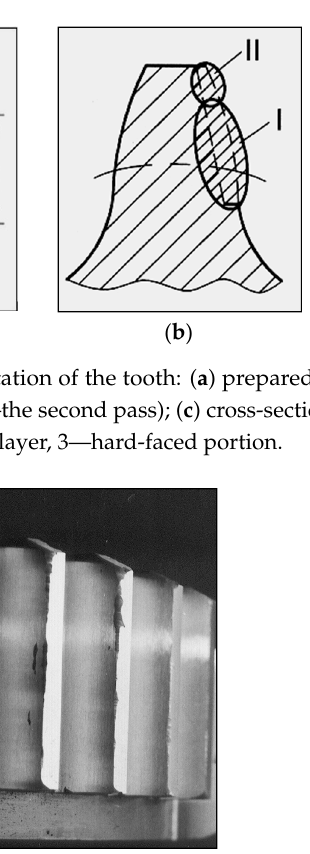
Figure 3. Appearance of the tooth regenerated by hard-facing.